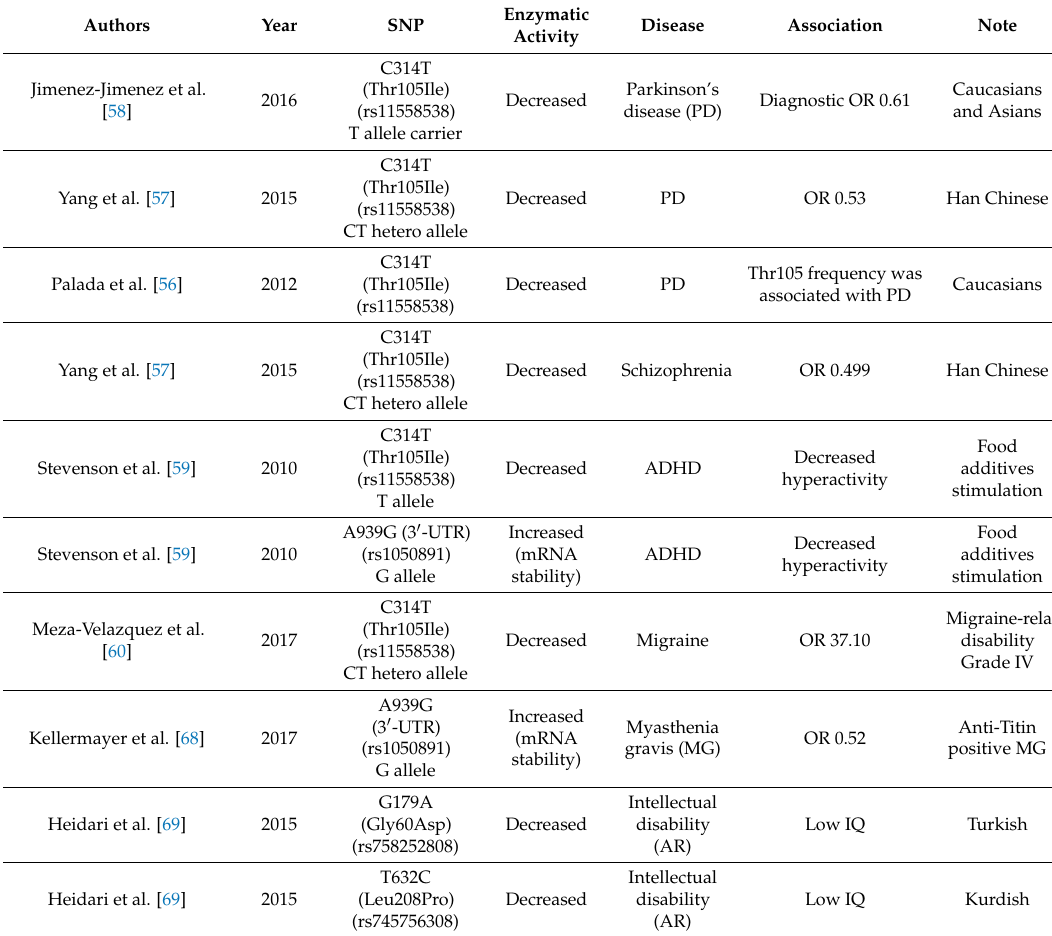
Table 2. Human HNMT mutations and brain